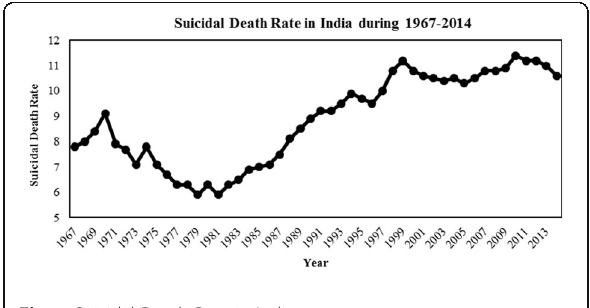
Fig. 1 Suicidal Death Rate in